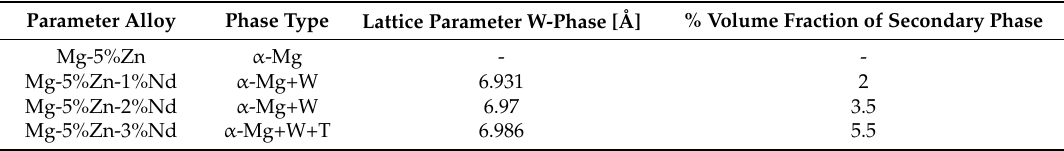
Figure 4. X-ray diffraction analysis of ( a ) Mg-5%Zn ( b ) Mg-5%Zn-1%Nd, ( c ) Mg-5%Zn-2%Nd ( d ) Mg- 5%Zn-3%Nd.